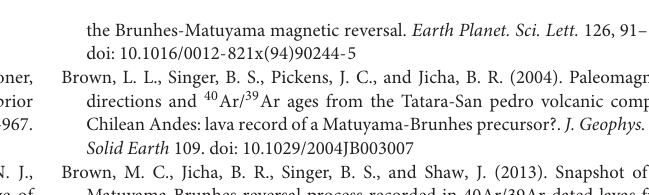
FIGURE S1 | NRM/ARM determined at different demagnetization steps for 8 samples. FIGURE S2 | H 1 / 2 and M rs /M s versus